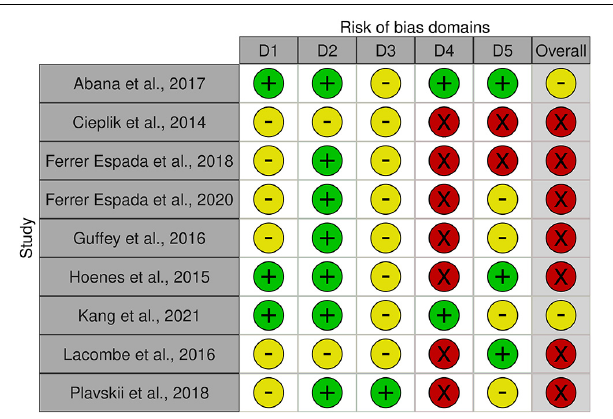
FIGURE 8 | Risk of bias assessment using traffic light plots and domain level judgments for each study using the Robvis-tool [Risk of bias tools—robvis (visualization tool)]. Five domains were considered based on Higgins et al. (2020) (D1: bias to randomization; D2: Bias due to deviations from intended interventions; D3: Bias due to missing data; D4: Bias due to outcome measurement; D5: Bias to selection of reported results). Judgments are based on multiple criteria and marked as + in green field: low risk,—in yellow field: some concerns and—in red field: high risk (see Supplementary Table 2